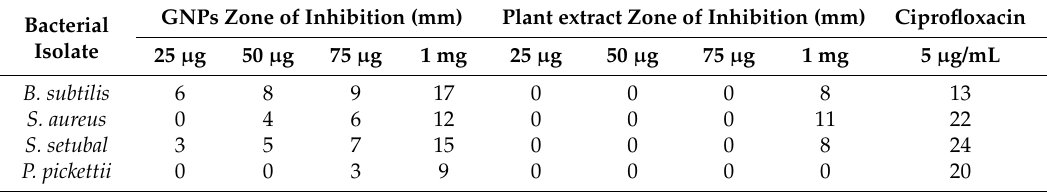
Table 3. Antibacterial assay of extract and gold nanoparticles (GNPs).